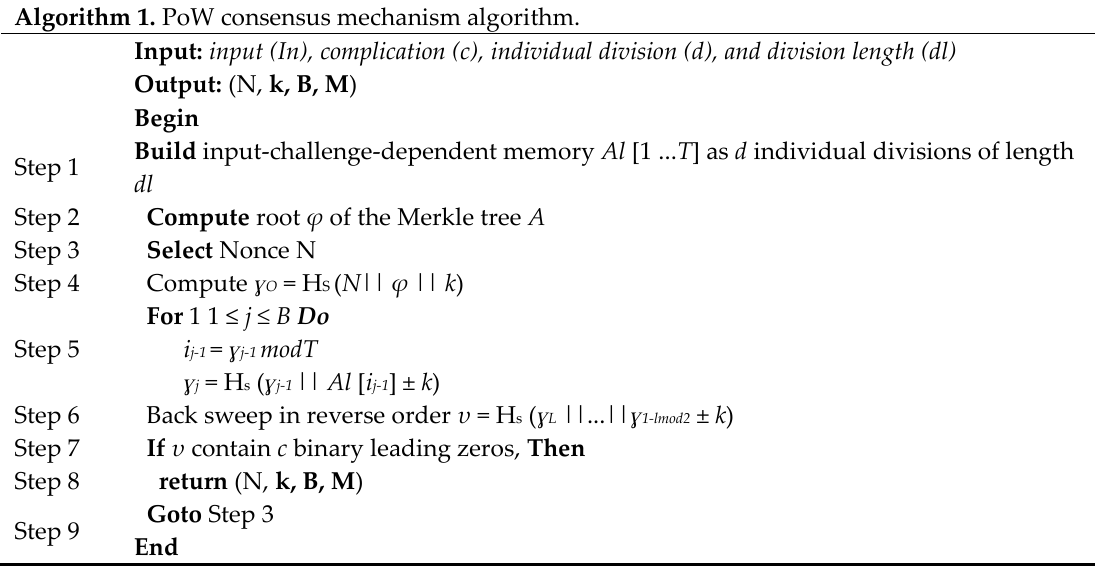
Algorithm 1. PoW consensus mechanism